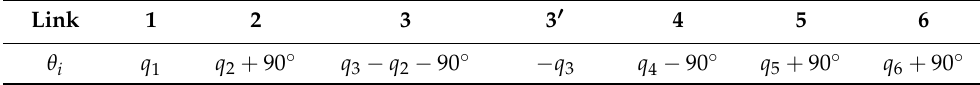
Table 1. D-H parameters of the puncture arm expressed by generalized variables.